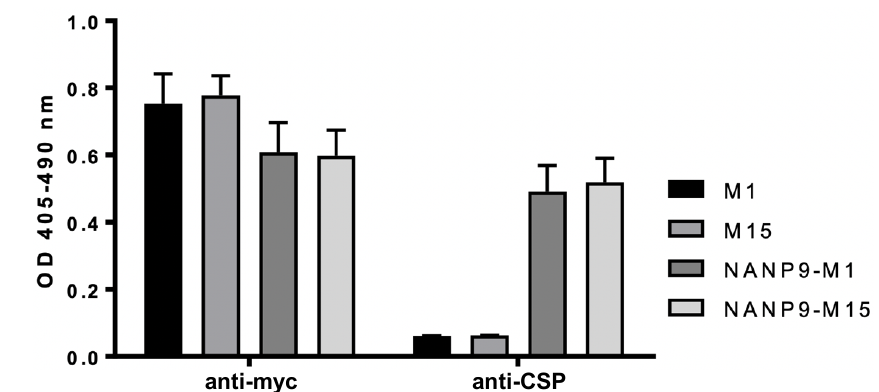
Figure 3. Immuno-detection of NANP9-chimeric HBsAgS proteins by ( A ) immunoprecipitation and